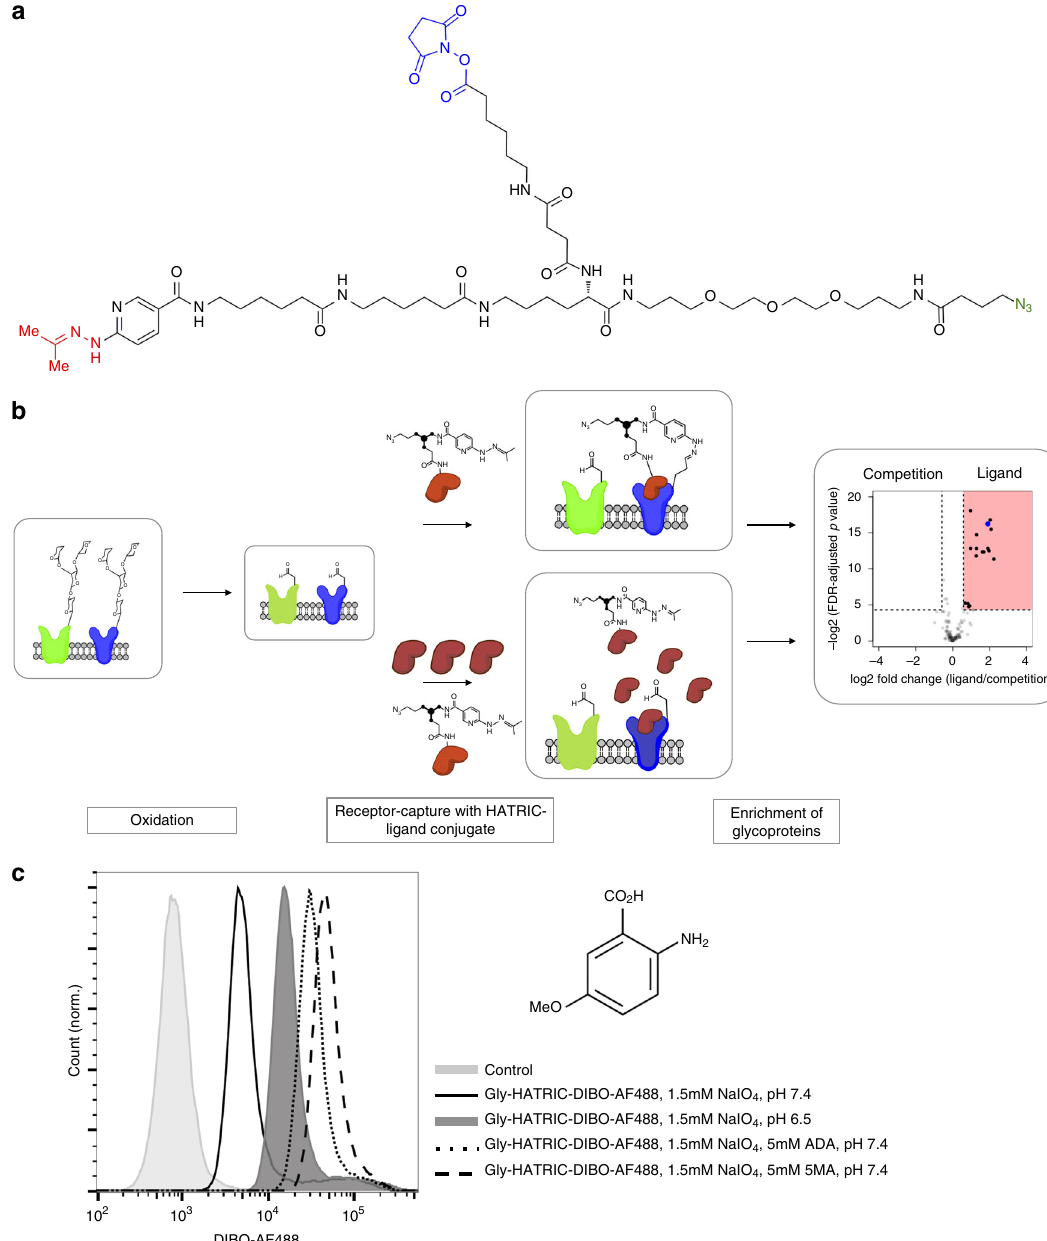
Fig. 1 HATRIC-LRC enables ligand-based receptor capture. a Structure of hydrazone (highlighted in magenta) and azide (highlighted in turquoise) containing tri-functional compound HATRIC (NHS ester highlighted in blue). Mw = 1171.4 g mol − 1 (synthesis described in Supplementary Note 1). b Work fl ow of HATRIC-LRC for identi fi cation of target receptors of ligands on living cells. First, living cells are mildly oxidized with 1.5 mM NaIO4. HATRIC, conjugated to the ligand of interest, is added to living cells. The ligand selectively directs HATRIC to its glycoprotein target receptor, where HATRIC reacts to generate azide-tagged cell-surface glycoproteins catalyzed by 5-MA. In order to identify target receptors of orphan ligands, a dual track experimental setup is employed. In the control, the HATRIC-conjugated ligand is applied to the cells in the presence of an excess unmodi fi ed ligand. Alternatively, HATRIC can be quenched with glycine for a negative control or a ligand with known target receptors can be employed as a positive control (not depicted in fi gure). After lysis and af fi nity puri fi cation of azide-tagged proteins with unbound proteins removed by harsh washing, peptides are proteolyzed with trypsin. Peptides are identi fi ed with high-accuracy mass spectrometry in a data-dependent acquisition mode followed by quantitative comparison of peptide fractions? from experiment and control to reveal speci fi c enrichment of candidate cell surface receptors. Target receptors are de fi ned as proteins that have a fold change of >1.5 compared to the control as well as an FDR-adjusted p value (Benjamini – Hochberg method) equal to or smaller than 0.05, corresponding to a target receptor window in the volcano plot that is framed by dotted lines and highlighted in red. c Flow cytometry traces of U-2932 cells incubated with HATRIC conjugated to dibenzocyclooctyne-Alexa Fluor 488 (DIBO-AF488) at pH 6.5 or pH 7.4 in the presence or absence of organocatalyst 5-methoxyanthranilic acid (5-MA) (structure shown, Mw = 167.16 g mol − 1 ) or 2-amino-4,5-dimethoxy benzoic acid (ADA). HATRIC was quenched with glycine (Gly − ) to avoid potential reaction of HATRIC ’ s NHS-ester with amino groups at the cell surface. Shift to the right indicates more ef fi cient labeling with